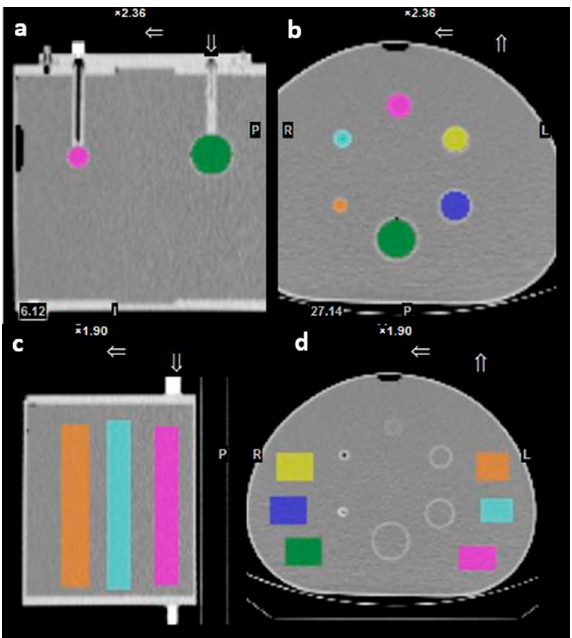
Fig. 2 a , b Spheres and c , d background volumes of interest (VOIs) drawn on the NEMA IQ Cal. phantom using the General Electric Dosimetry toolkit (GE DTK)